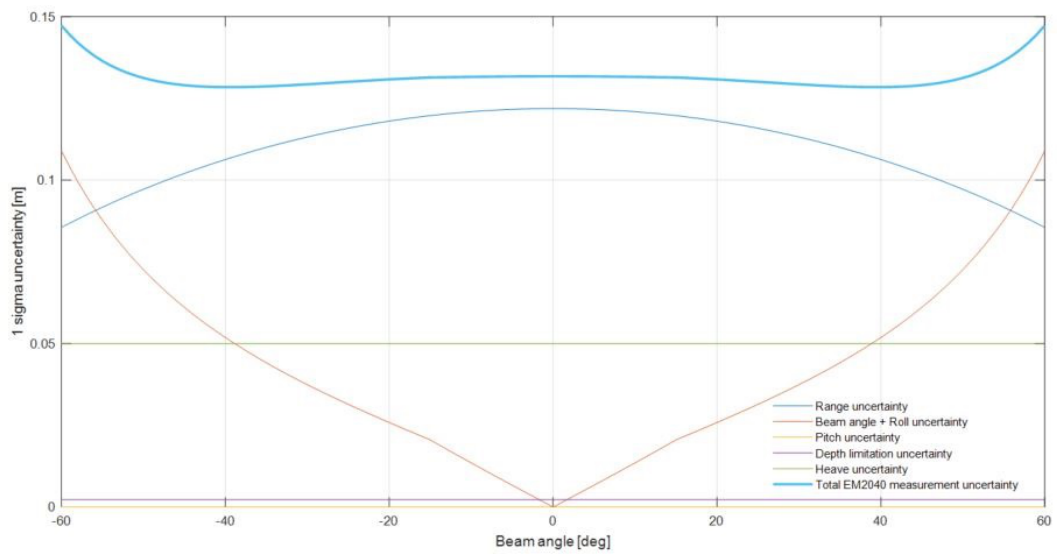
Figure 15. Uncertainties related to the EM 2040 depth measurement. The AUV altitude equals 60